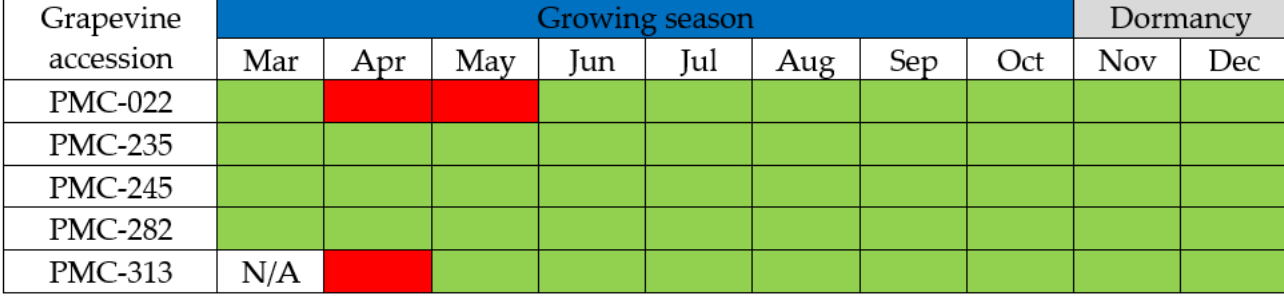
Figure 2. Detection of GBV-1 in five grapevine accessions by real-time PCR during the 2020 growing season and dormancy. Positive results are shown in green, while negative results are shown in red; N/A—not available.